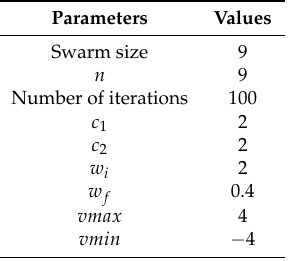
Table 3. Parameters of